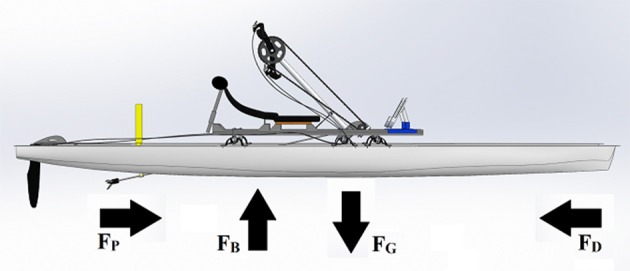
3D CAD model of the Handwaterbike and a free body diagram of the forces acting on the system. FP, propulsive force; FB, buoyant force; FG, gravitational force; FD, drag force.